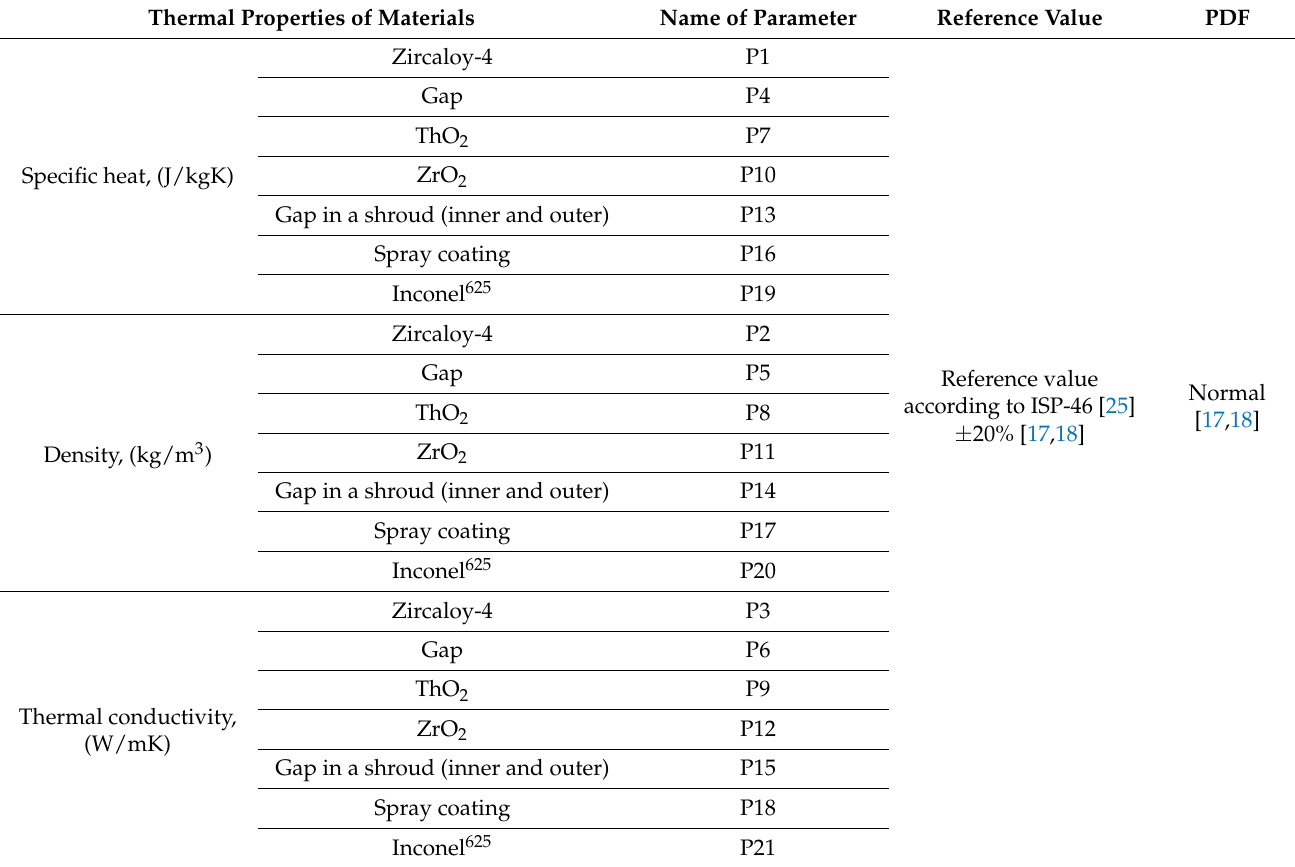
Table 1. Uncertainty characterization of thermal properties of materials used for RELAP/SCDAPSIM modelling of PHEBUS FPT 1